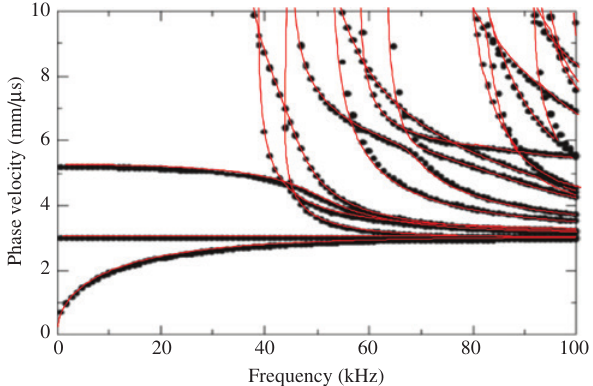
Figure 2: Phase velocity dispersion curves for the steel square bar; dotted lines: results from the semi-analytical finite element method [22]; solid lines: the authors’ results.